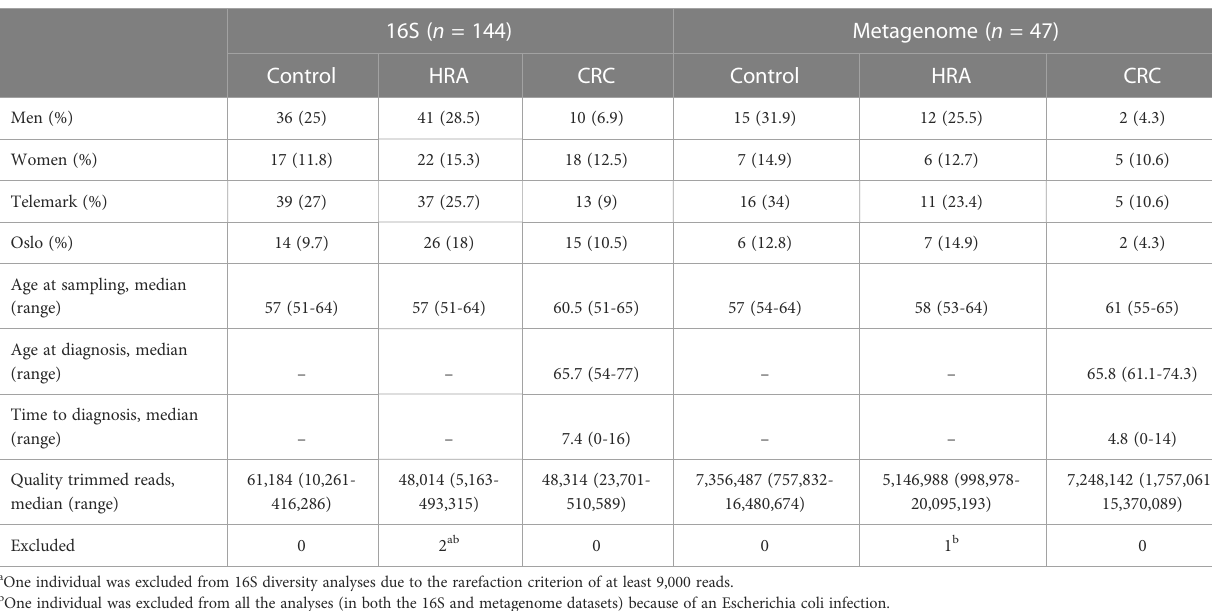
TABLE 1 Characteristics of the study participants and samples.